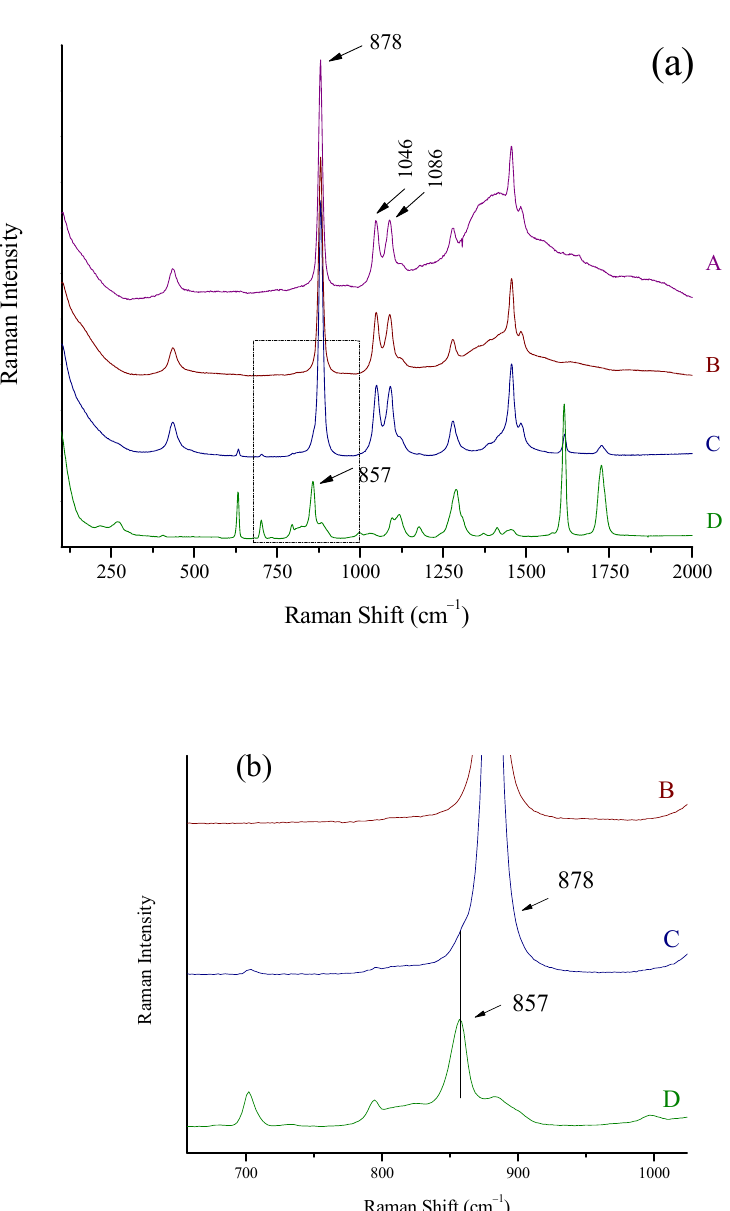
Figure 5. ( a ) Raman spectra of (A) ouzo, Varvagianni (42% vol), (B) vodka, Stolichnaya (40% vol), (C) gin, Beefeater (47% vol), and (D) the plastic container of Beefeater gin. The Raman portable system and the “through the container” method were used. Major ethanol peaks at 878, 1046, and 1086 cm −1 and the 857 cm −1 peak of the plastic bottle are marked. ( b ) Zoomed area of ( a ) in spectral area 700–1000 cm −1 . The peak of plastic container at 857 cm −1 as a shoulder of the peak of ethanol at 878 cm −1 in the spectrum of Beefeater gin is